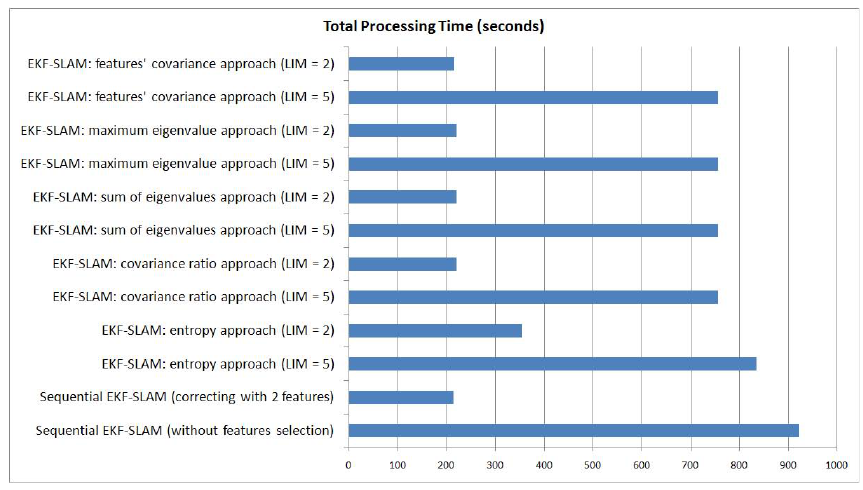
Figure 18. Accumulated processing time associated with each EKF-SLAM with feature selection criterion